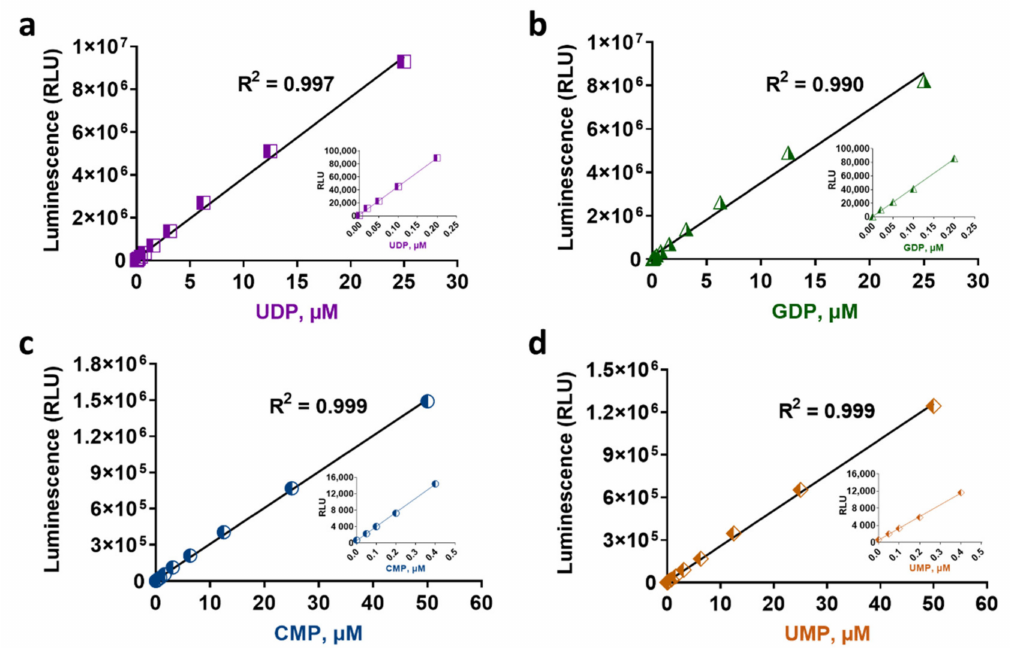
Figure 2. Linearity and sensitivity of bioluminescent nucleotide assays. The UDP-Glo ( a ) and GDP-Glo ( b ) assays can detect up to 25 µ M, and the UMP/CMP-Glo ( c , d ) can detect up to 50 µ M of the corresponding nucleotides. Luminescence values represent the mean of three replicates. RLU = relative light